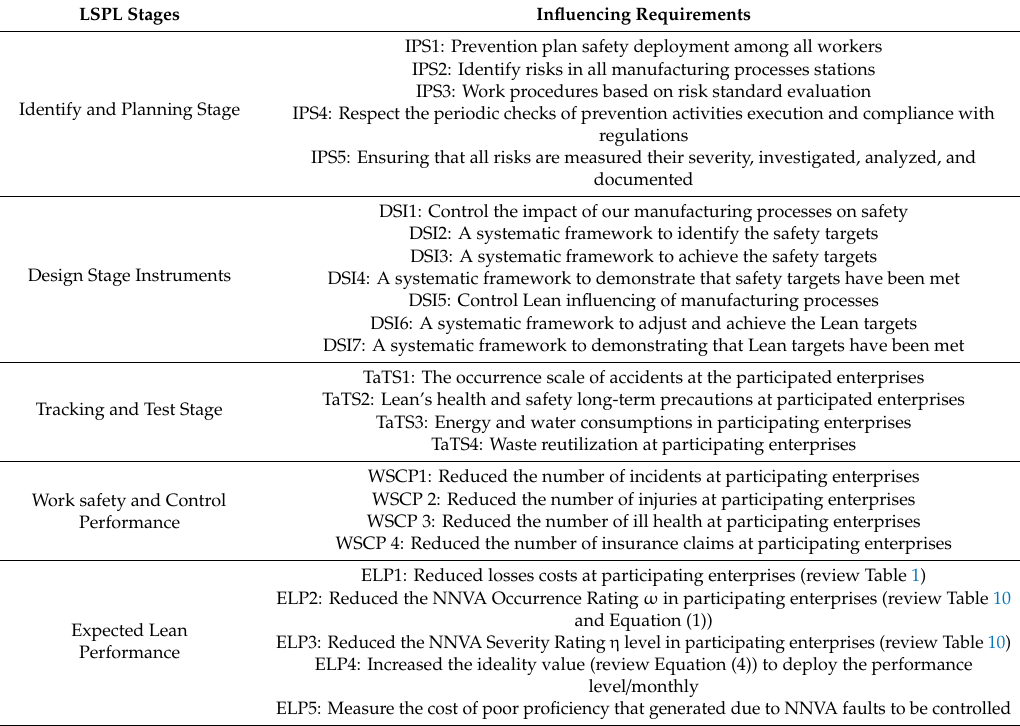
Table 12. Questionnaire outlines that activate the LSPL framework